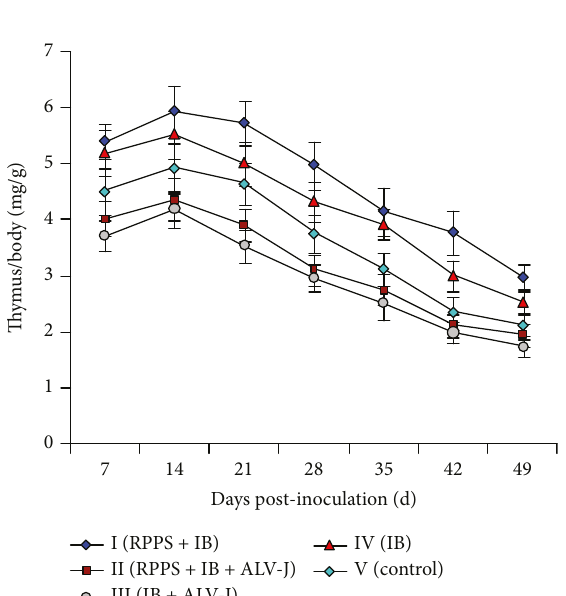
Figure 2: Changes of the bursa index.